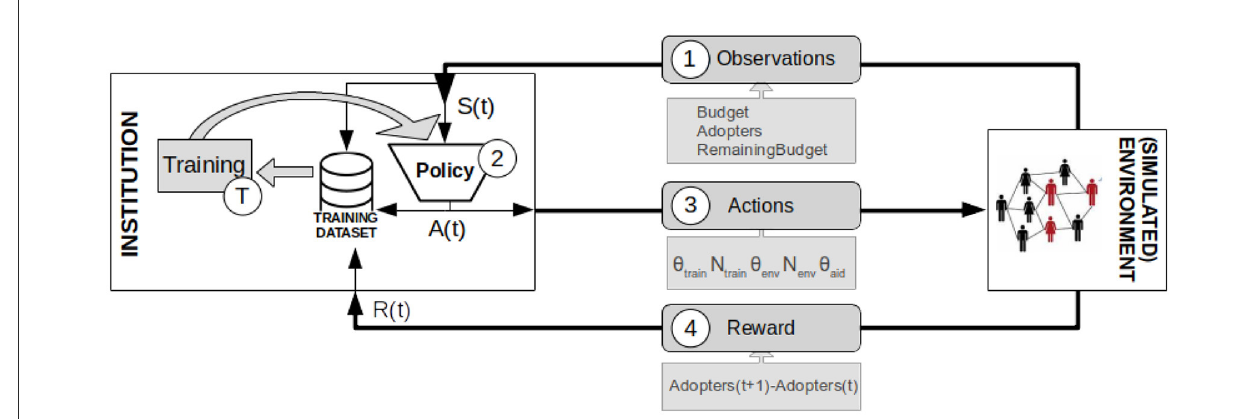
FIGURE2 Schematic overview of the interactions between the institution (the learner) and the environment during the different RL steps.